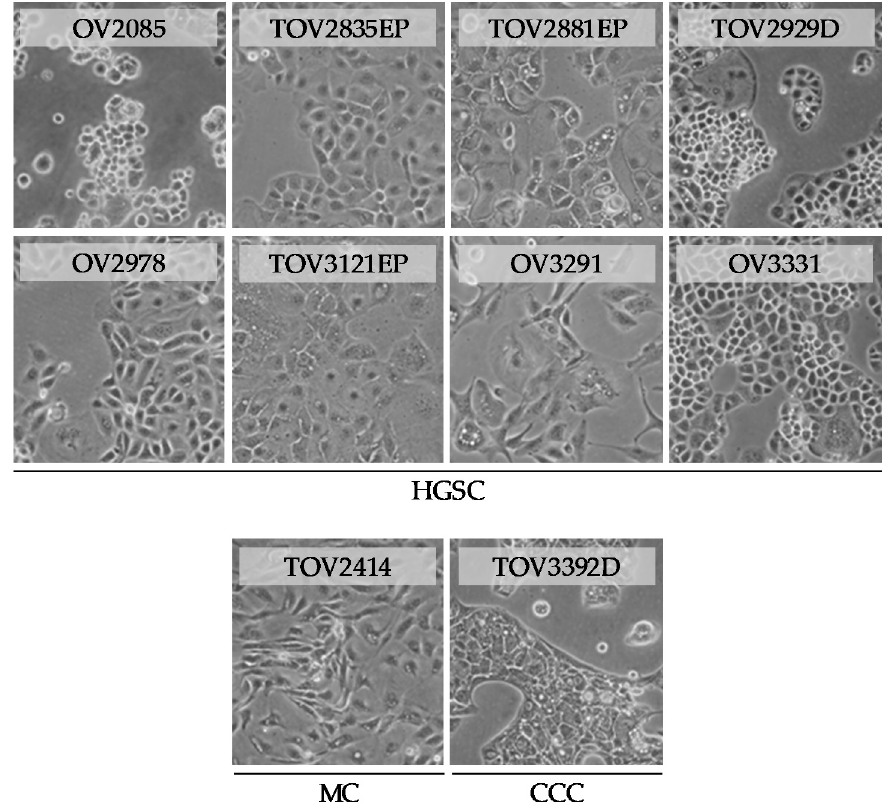
Figure 1. Morphology of 10 new patient-derived epithelial ovarian cancer (EOC) cell lines. Shown are brightfield microscopy pictures of each cell line, between passages 60 and 75, except in the case of OV3291, represented at passage 33. At these passages, cells exhibited uniform morphology, and cell lines were devoid of fibroblast-shaped cells. All pictures were taken at a magnification of 100×.